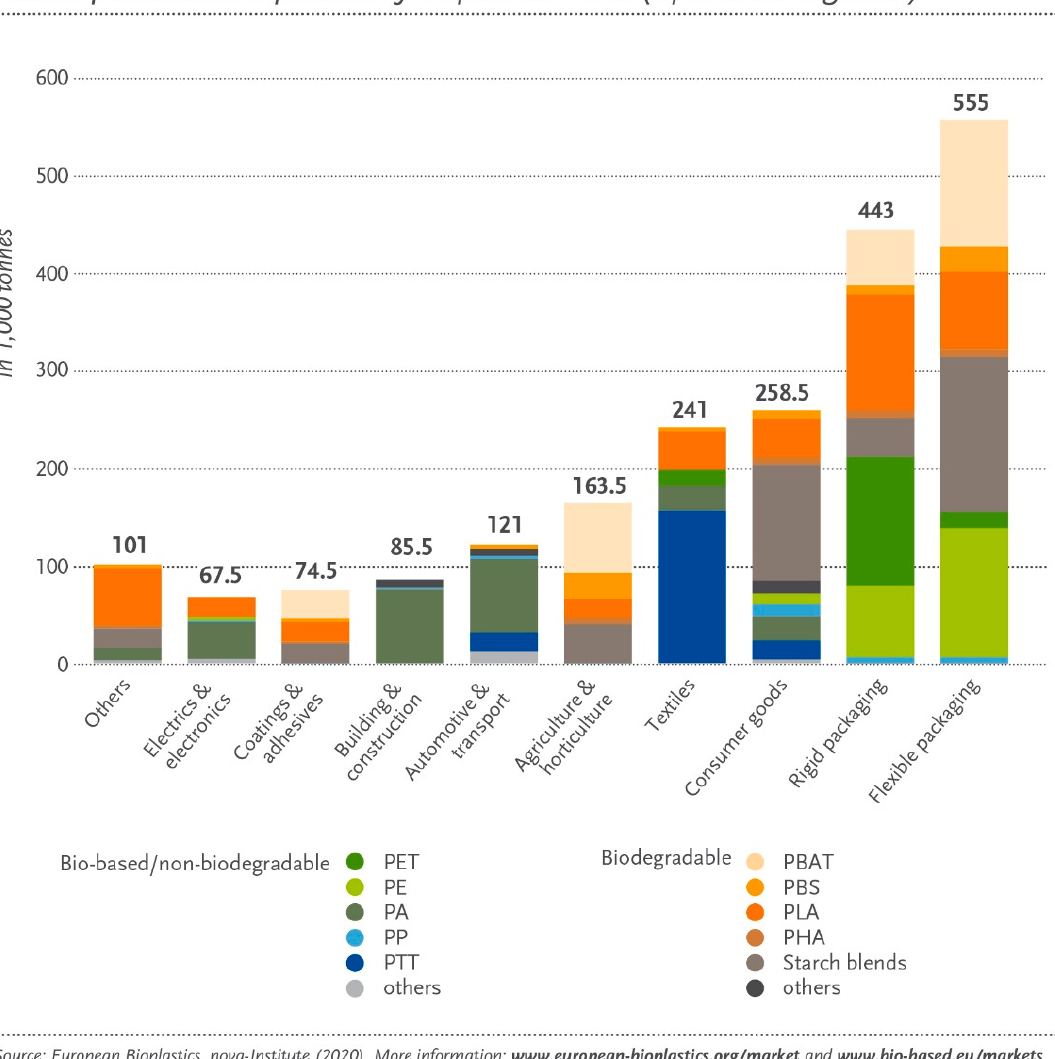
Figure 4. Biodegradable plastics by segments (2020) [19] (accessed on 5 March 2021).